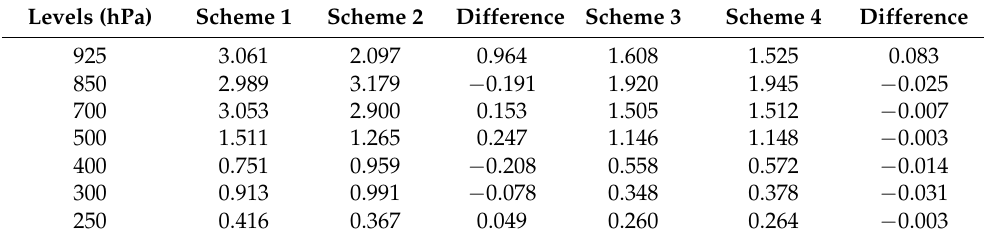
Table 4. RMSE (g/m 3 ) of WVD recovered from each scheme at each standard pressure level.